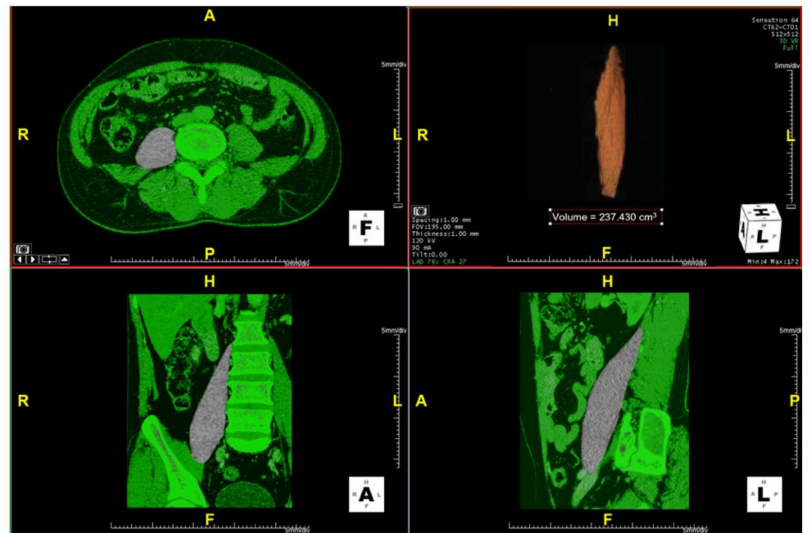
Figure 1. Images demonstrating the method of the psoas major muscle volume measurement by a CT-based software. Measurements are from the origin of the psoas major at the level of the lumbar vertebrae to its insertion in the lesser trochanter on CT datasets using a semi-automatic segmentation method. (A, anterior; P, posterior; R, right; L, left; H, head; F, foot). After placement and adjustment of the self-retaining retractor allowing direct visual- ization of the intervertebral disc area, a complete discectomy was performed. The endplate preparation was carried out with caution to minimize the risk of intraoperative endplate injury, which can lead to an early postoperative cage subsidence. Trials were inserted, and a proper sized polyethylethylketone (PEEK) filled with demineralized bone matrix (Attrax, NuVasive Inc., San Diego, CA, USA) was then impacted in a proper position and confirmed by fluoroscopy. The lateral plate was securely fixed at this step (24 patients). The retractor was removed; at this point, the bleeding was thoroughly controlled and the skin was closed in a subcutaneous fashion with no drain retention. The patient was subsequently placed in the prone position, and bilateral percutaneous pedicle-screw fixation was performed under fluoroscopy guidance (Precept, NuVasive Inc., San Diego, CA, USA) (48 patients). Within 24 h after surgery, all patients were examined and asked whether they devel- oped any new symptoms such as anterior thigh pain, numbness at the groin or front thigh, motor score (Lovett scale) for hip flexor motor strength. Patients were considered having